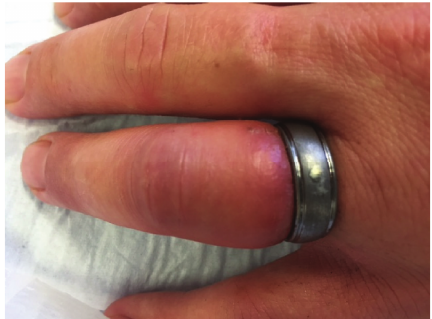
Figure 1: Patient’s hand on presentation.